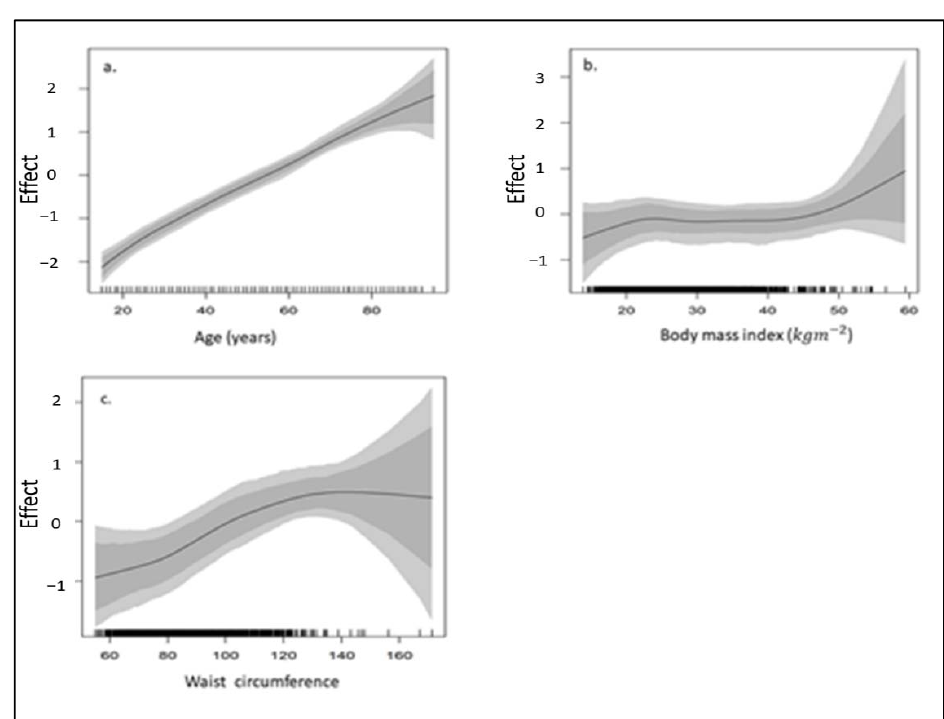
Figure 5. Non-linear smooth function plots of the effects of ( a ) age, ( b ) body mass index (BMI) and ( c ) waist circumference, on the prevalence of hypertension in South Africa based on the adjusted model fitted to the 2016 DHS dataset.